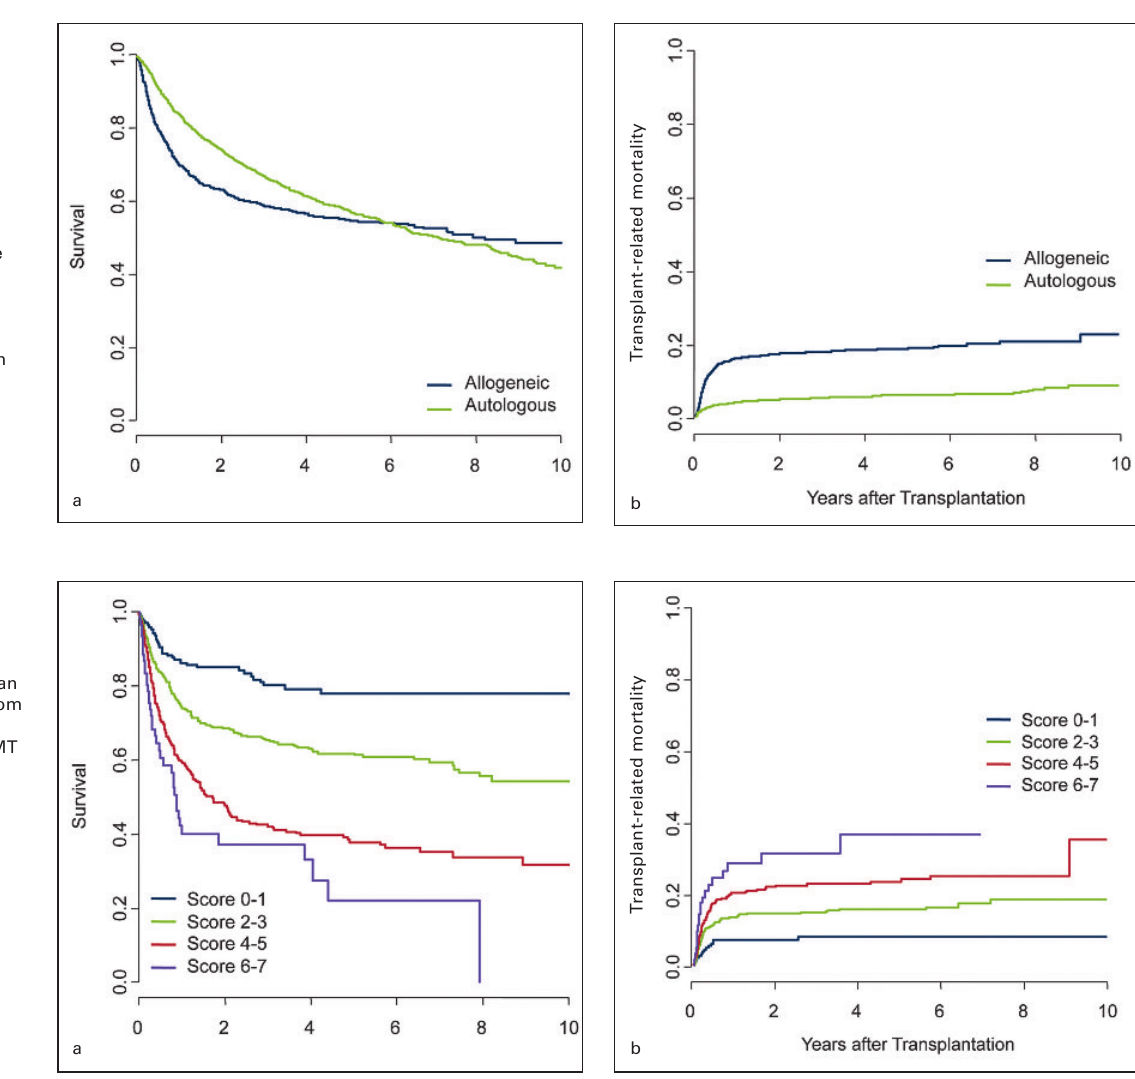
Survival- and transplantation- related mortality of 3808 patients